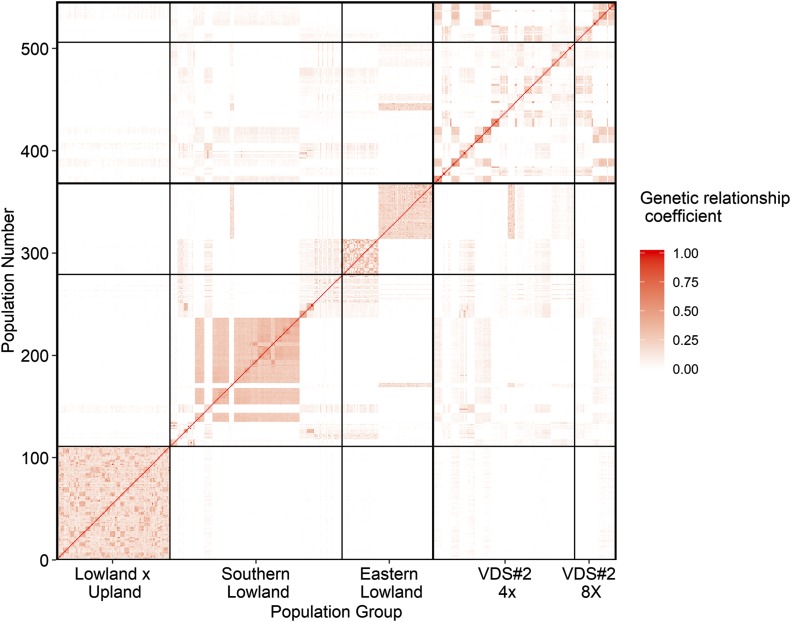
Marker-derived genomic relationships (identify-by-state, IBS) for 368 switchgrass half-sib families in the genomic prediction training set (bold bordered area) and Validation data set #2 (VDS #2). The label “Population number” on the y-axis refers to an arbitrary number assigned to 368 half-sib families of the training set plus 178 individuals in VDS #2.